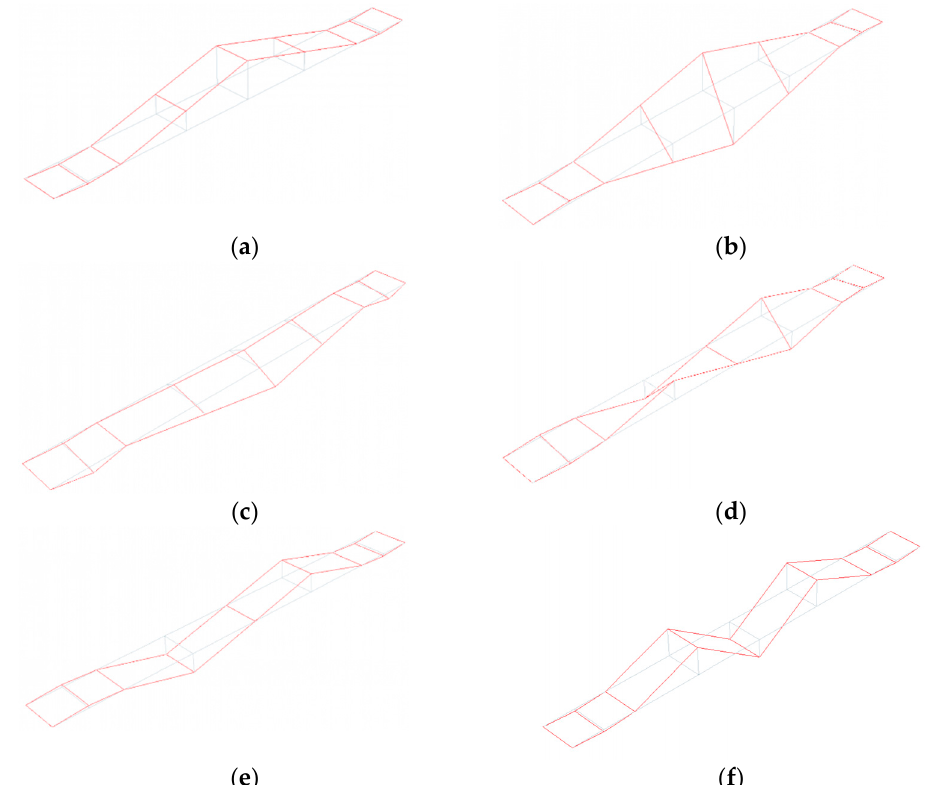
Figure 15. The six experimental mode shapes of the footbridge: ( a ) first (vertical), ( b ) second (tor- sional), ( c ) third (lateral), ( d ) fourth (vertical), ( e ) fifth (torsional), ( f ) sixth (vertical). The Rayleigh mass and stiffness proportional damping model was used for the nu- merical simulations [32]. Based on obtained logarithmic decrements (see Table 3) for the first and fourth modes (both vertical), the coefficients of the Rayleigh damping model were estimated as 0.4548013 for the mass and 0.0000045 for the stiffness proportional damping. The dependence of the damping ratio on the frequency for the determined Rayleigh coefficients along with the damping ratios detected experimentally are por- trayed in Figure 16.